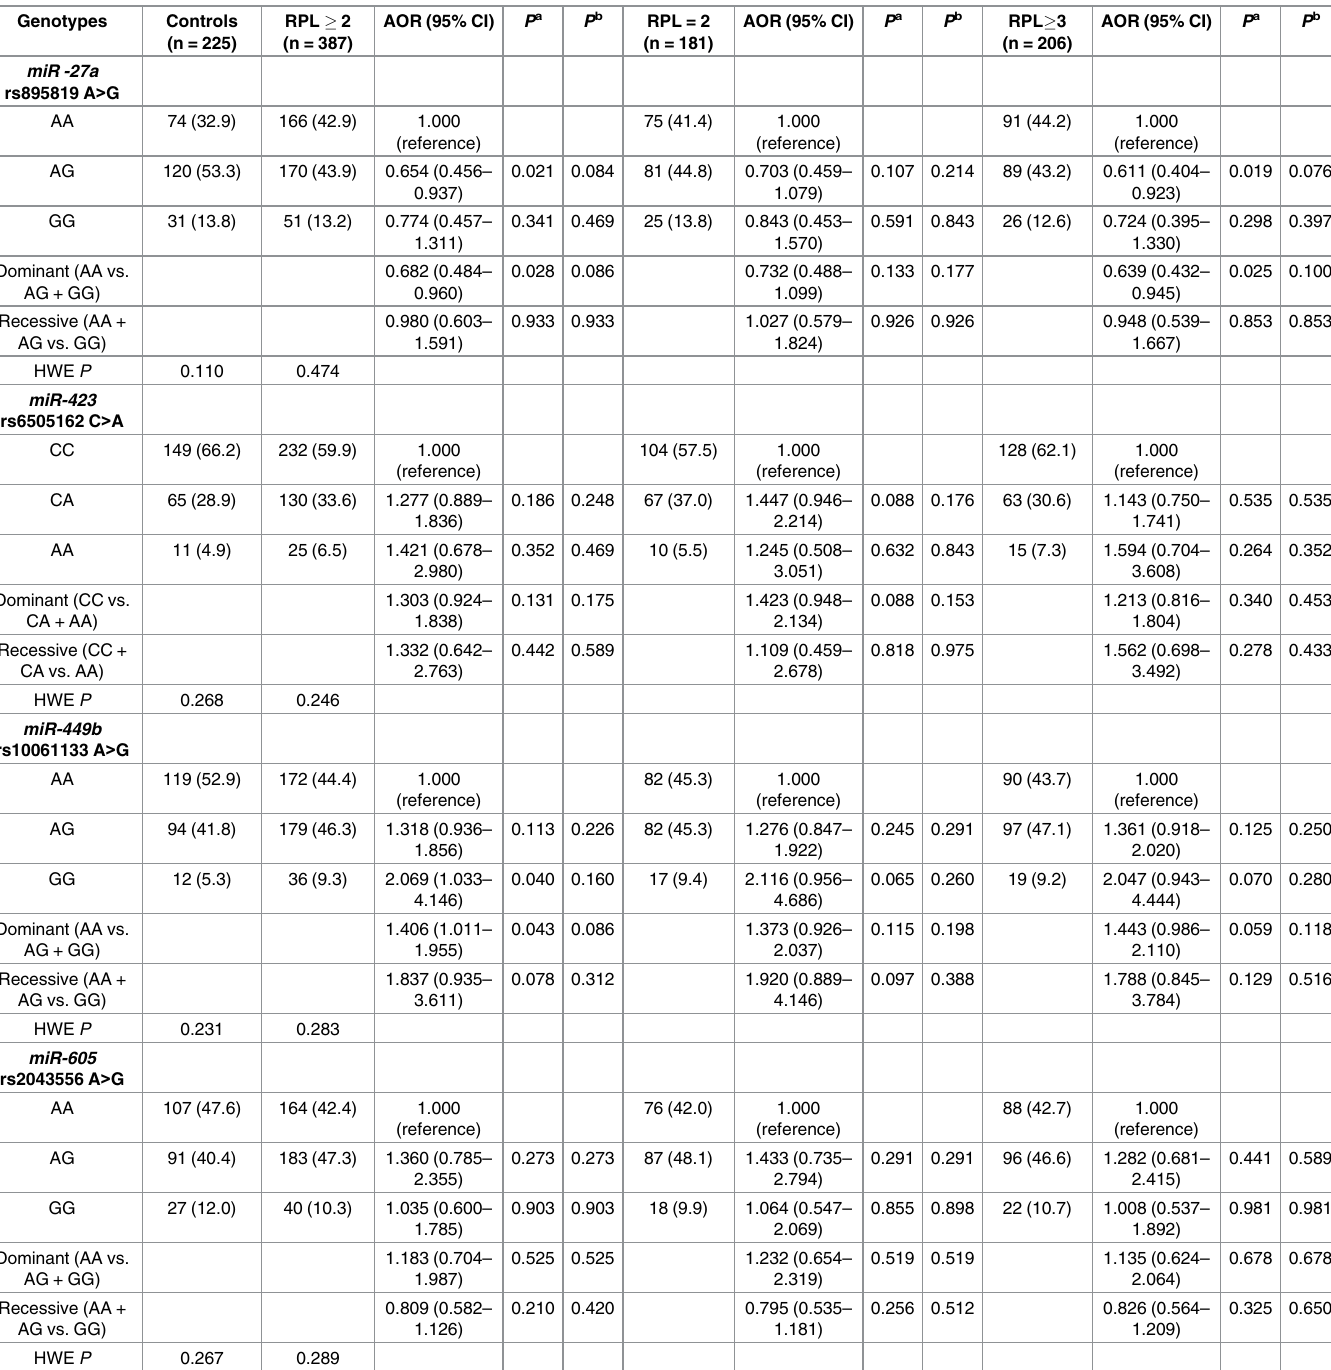
Table 2. Genotype frequencies of miR-27a A > G, miR-423 C > A, miR-499b A > G, and miR-605 A > G polymorphisms in Korean RPL patients and control